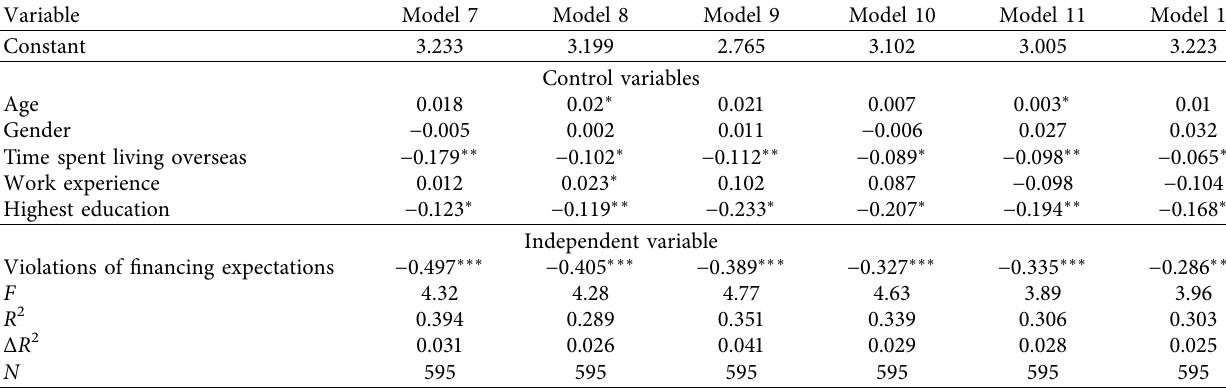
Table 5: Grouped regression analysis.